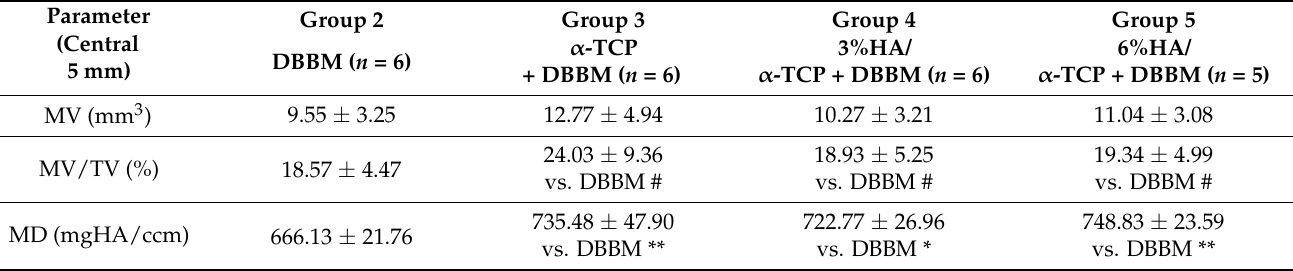
Table 3. Quantified micro-CT values in a central 5-mm defect VOI (VOI_2).